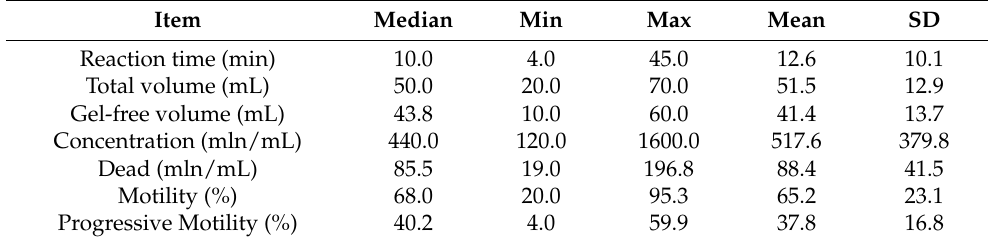
Table 2. Sperm Parameters of 26 Healthy